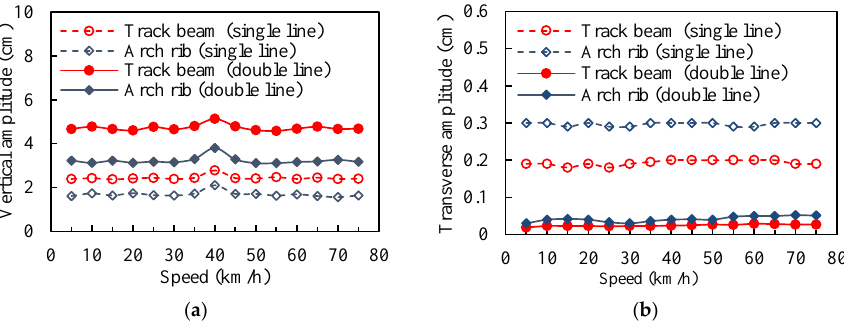
Figure 8. The displacements of the bridge at the mid-span: ( a ) the vertical direction ; ( b ) the transverse direction.